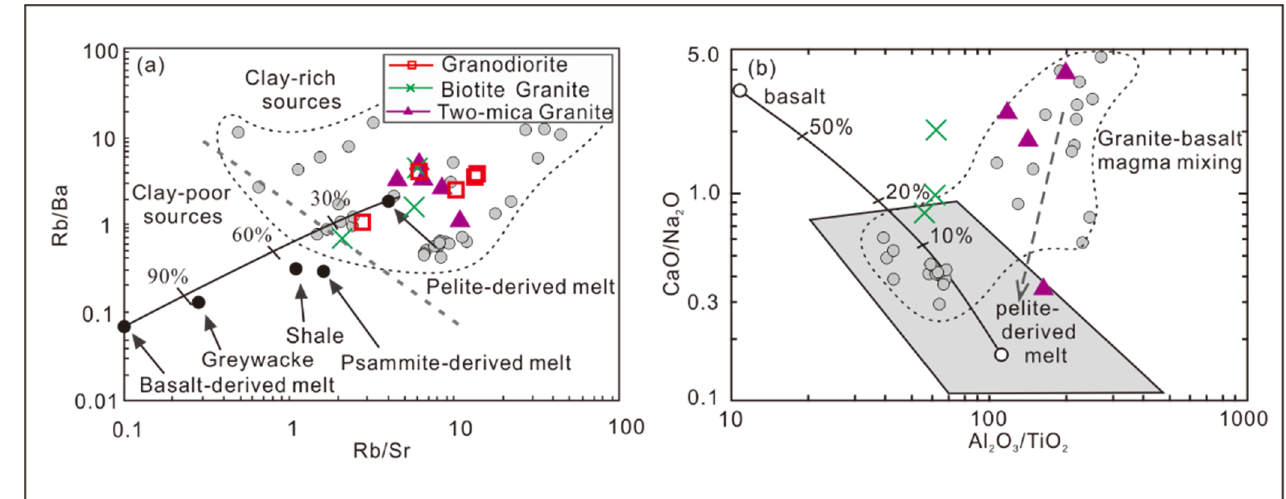
Figure 8. ( a ) Rb/Ba–Rb/Sr [80] and ( b ) CaO/Na 2 O–Al 2 O 3 /TiO 2 (after [80]; diagrams for the Zhuxi granites of the Jingdezhen area. The dashed line divides granitites derived mostly from clay-poor sources from those formed from clay-rich source rocks. The circles in the diagrams denote published data for the Zhuxi granites [38,42,43].